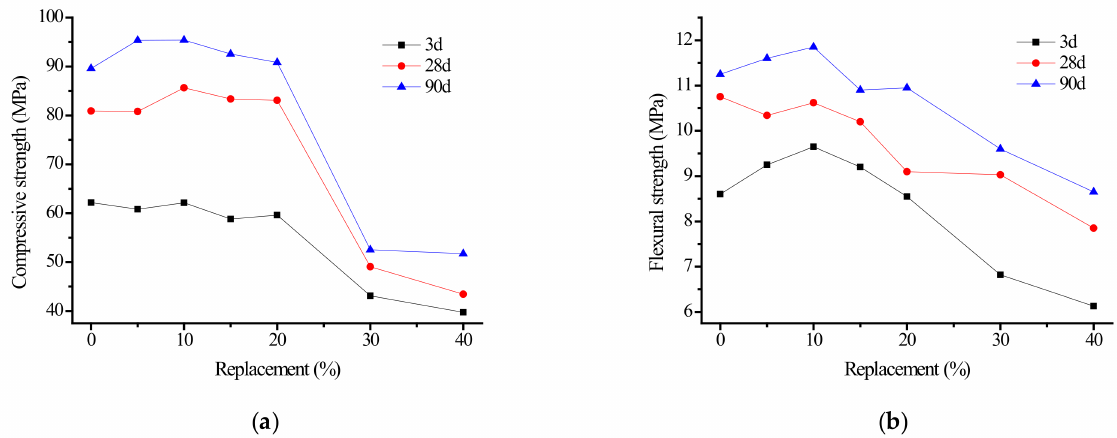
Figure 4. Effect of sand content on strength of alkali slag cement mortar. ( a ) Compressive strength, ( b ) Flexural